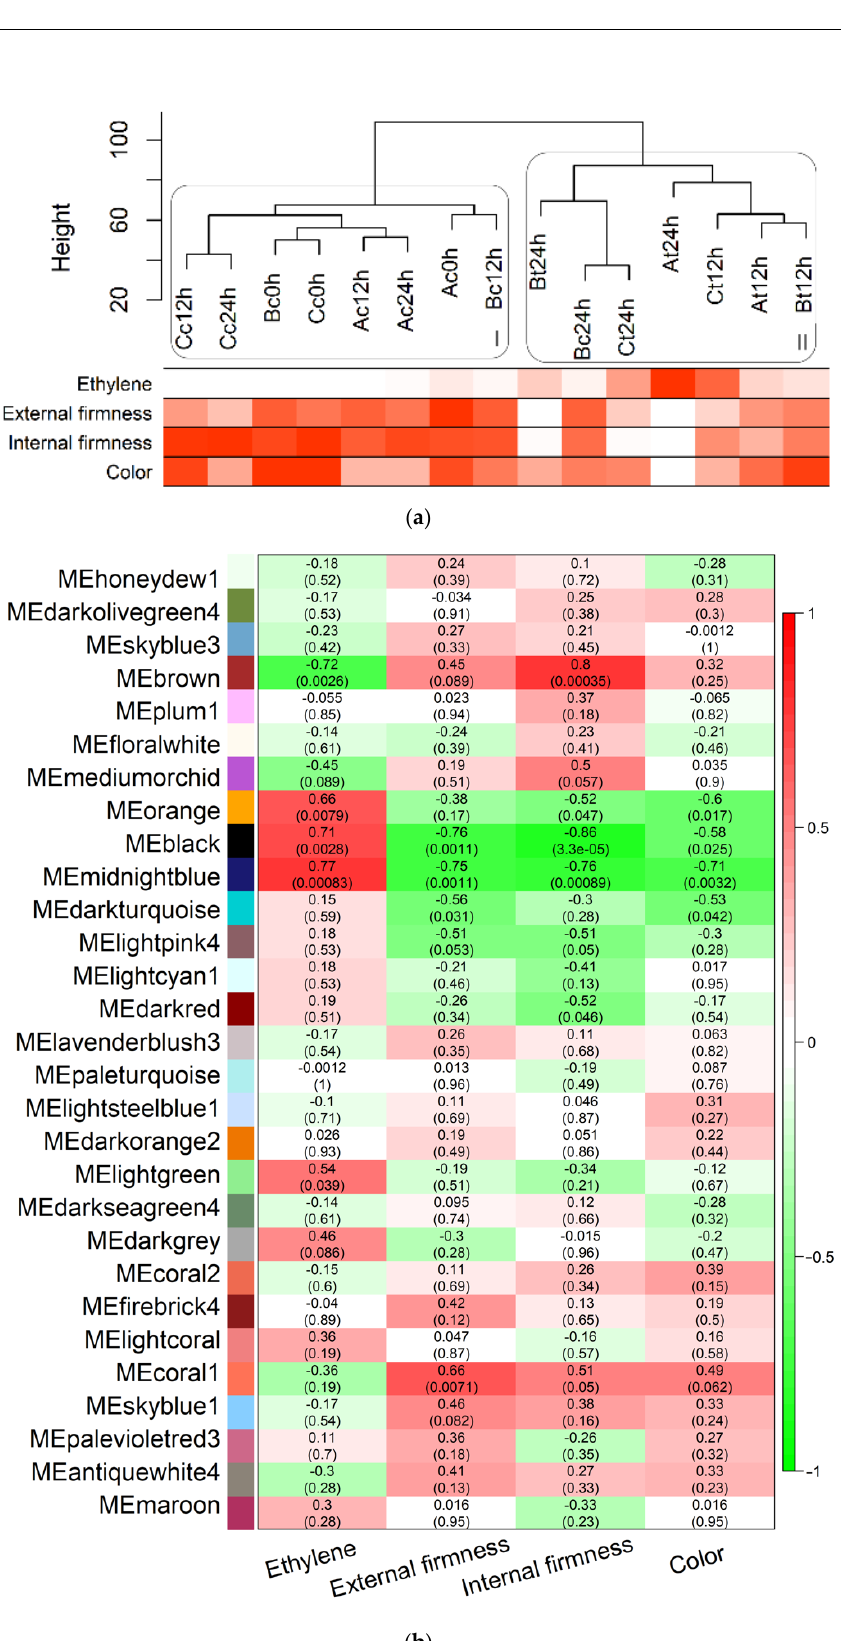
Figure 3. Sample dendrogram of transcriptomic data, phenotypic heatmap, and module-phenotype correlation: ( a ) Gene expression clustering of samples organized into two main clades (I—Control; II—Treated) and heatmap of the ripening parameter’s measures, in which white is low values and red is high values; ( b ) Heatmap of the correlation between modules and physiological